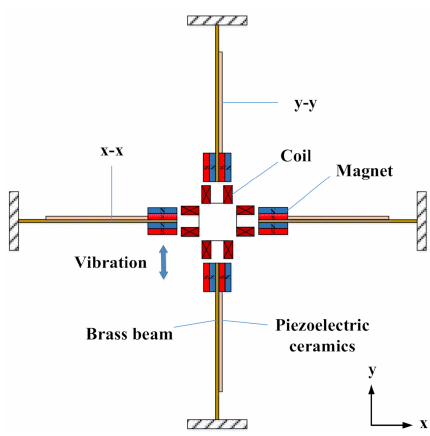
Figure 2. Schematic diagram of the structure of the energy harvester: ( a ) a schematic diagram of the cross-magnetically coupled piezoelectric–electromagnetic energy harvester; ( b ) a schematic diagram of the fixed permanent magnet at the end of the cantilever beam; ( c ) a schematic diagram of the fixed iron block at the end of the cantilever beam.